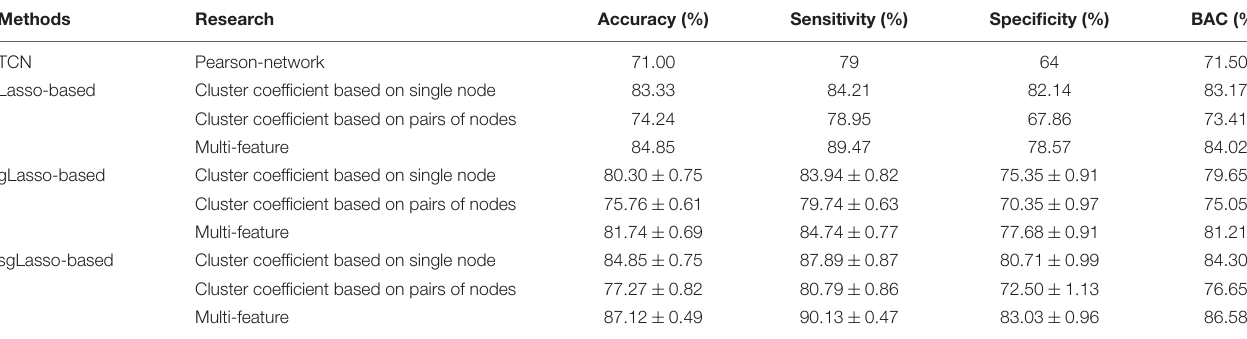
TABLE 4 | Classification performance of the three methods.